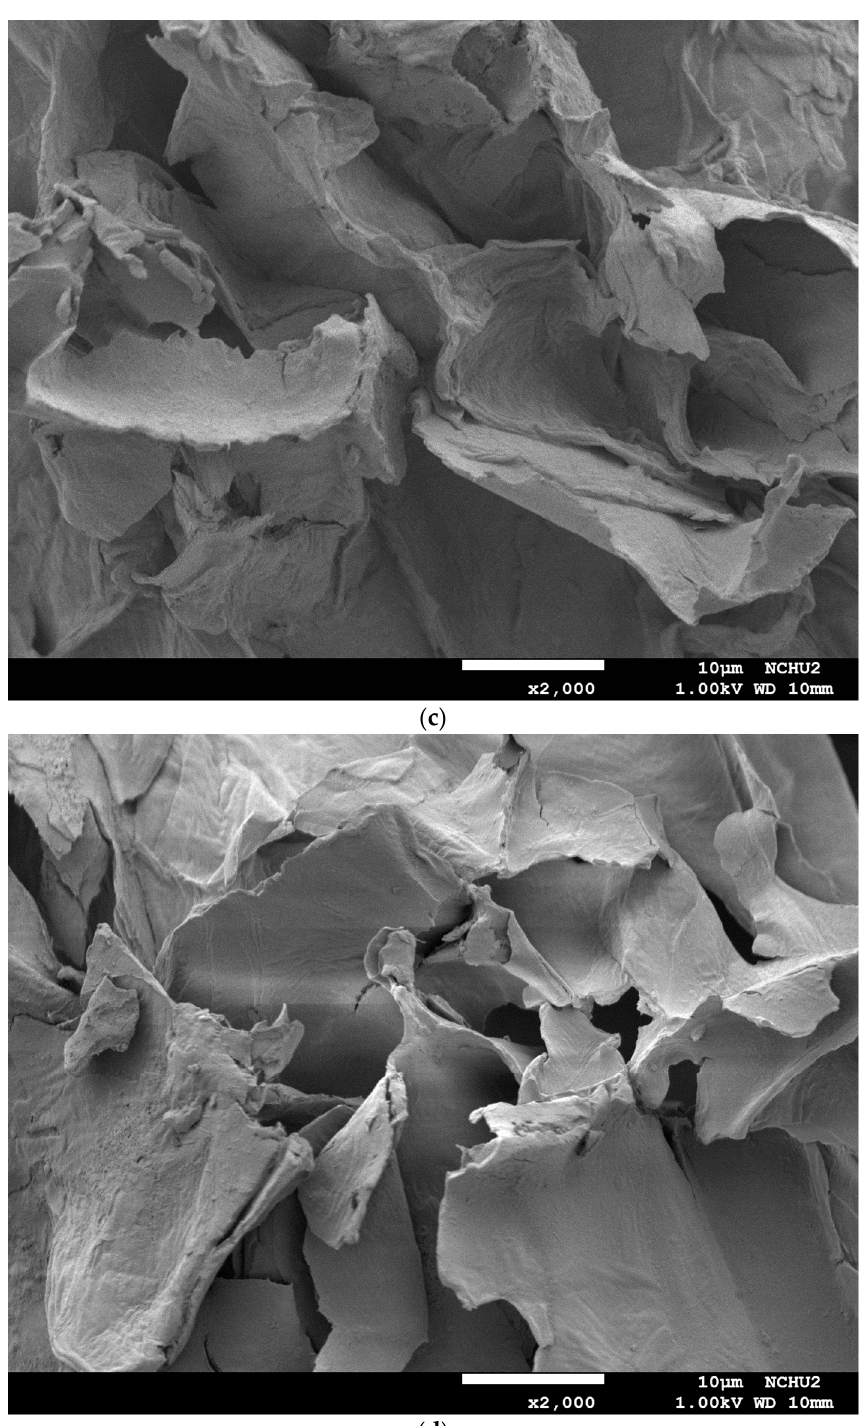
Figure 1. Comparison of FESEM images of dried burdock roots before and after extraction at 50 °C, 1/30 (g/mL-water) of solid-to-liquid ratio, and 10 min of extraction time: ( a ) dried burdock root powder before extraction (×2000); ( b ) extraction residue using 120 rpm of shaking (×2000); ( c ) extraction residue using 40 kHz of ultrasound (×2000); ( d ) extraction residue using 120 kHz of ultrasound (×2000).